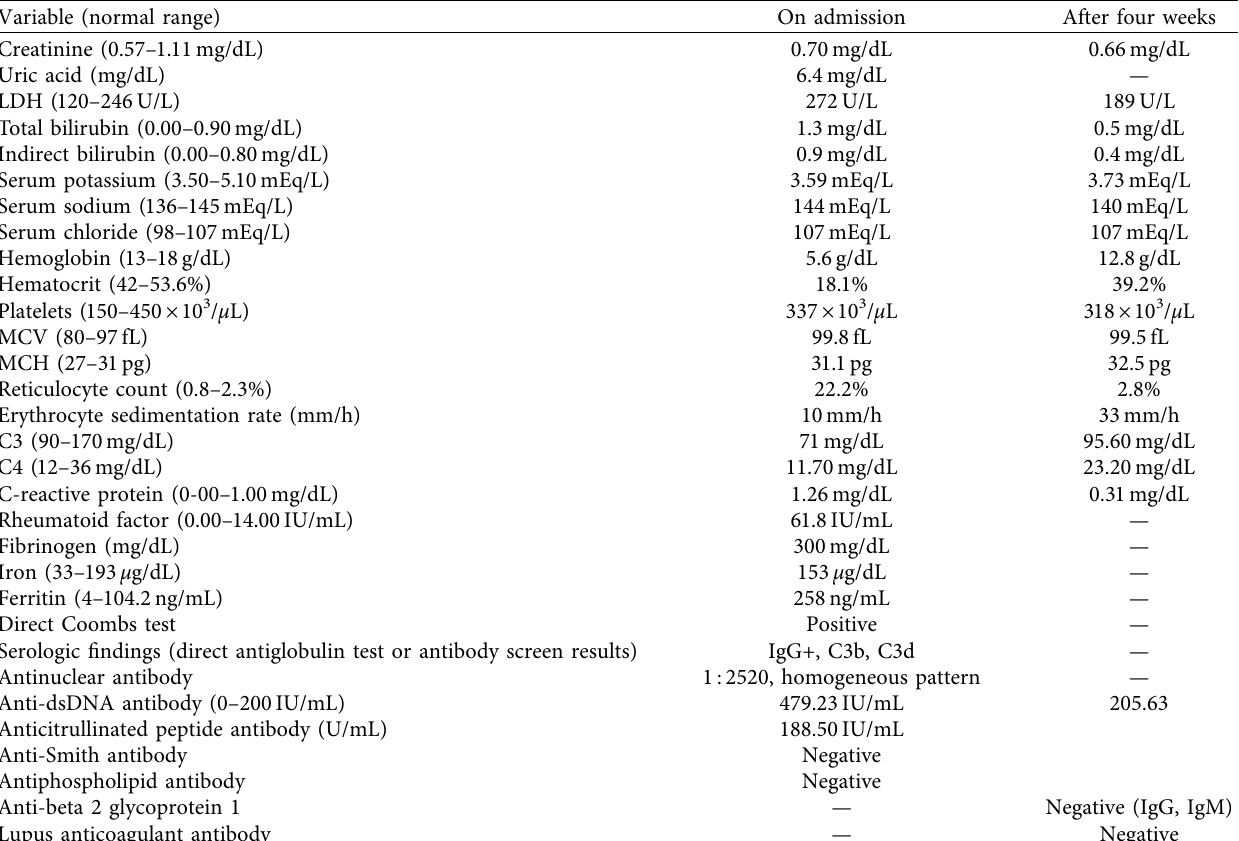
Table 1: Laboratory values.